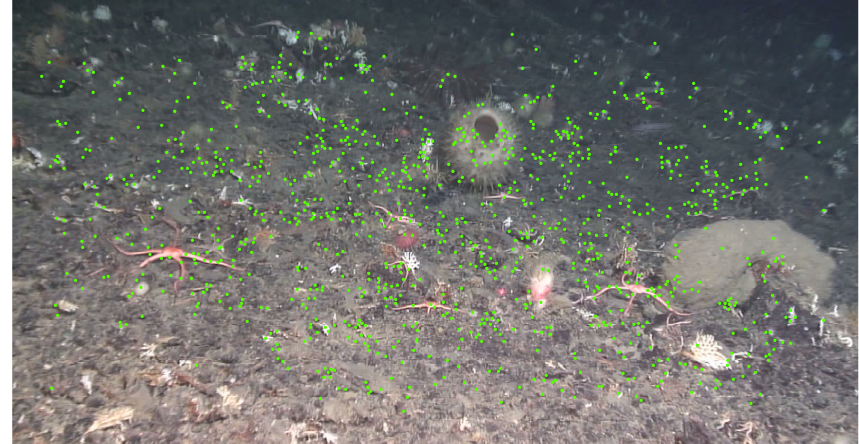
Fig. 2. SmartPoints (green dots) in PhotoModeler: automatic detection of natural features in a sample frame extracted from dive B.